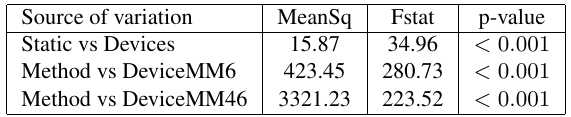
Table 11: ANOVA results for horizontal precision according